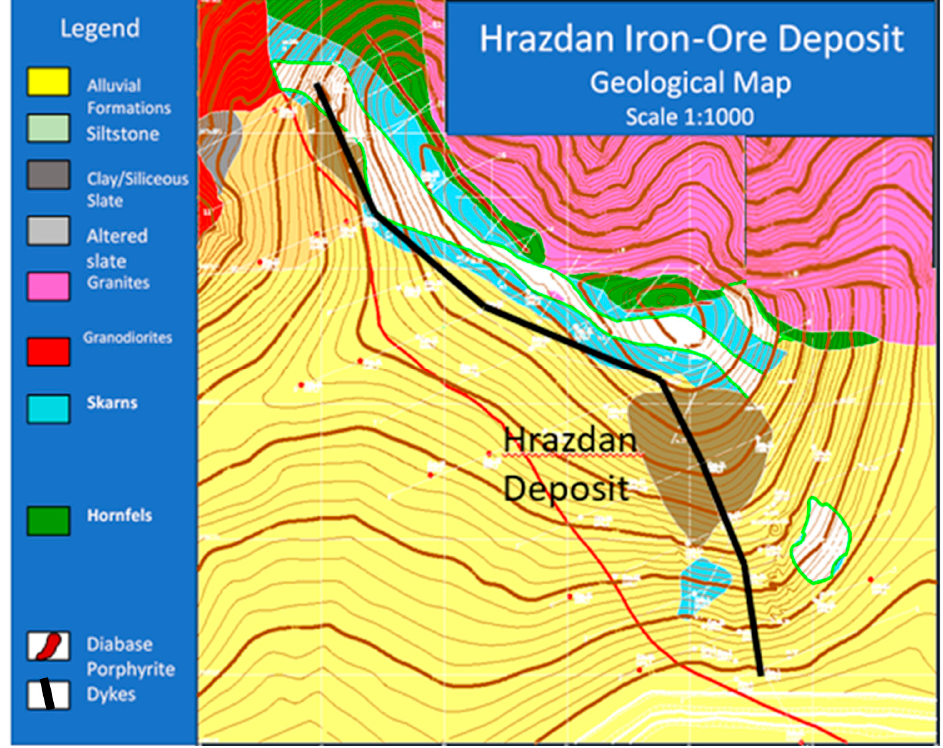
Figure 2. Geological map, Hzradan deposit [27]. The Hrazdan deposit is classed as an iron magnetite skarn. The term ‘skarn’ refers to the metasomatic replacement of carbonate rocks by calc-silicate assemblages such as Ca-rich garnet, pyroxene, amphibole and epidote. This occurs due to contact or regional metamorphism. The Hrazdan ore deposit is a typical iron-magnetite skarn formed through the metasomatic replacement of calcite-bearing rocks. The deposit is hosted within garnet- epidote dominated skarns and hornfels, which form the contact lithologies to granite intrusions emplaced in the Lower Eocene to the